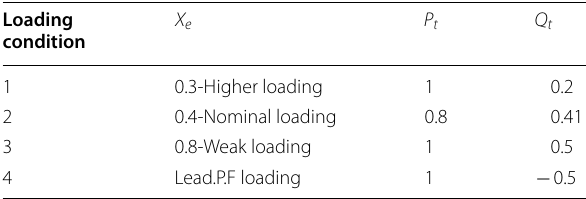
Table 1 Loading conditions considered for case 1 Loading